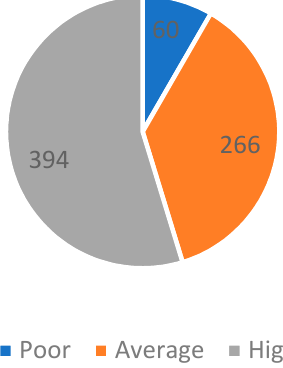
Figure 3. Patients’ satisfaction grade for telemedicine ( n = 720). In the present study, we performed binomial logistic regression analysis to find the associated factors for poor and average patient satisfaction towards telemedicine. satisfaction scores were age group more than 40 years (OR = 1.59; 95% CI = 1.04–2.44, p = 0.031), education less than University/College level (OR = 1.68; 95% CI = 1.07–2.15, p = 0.025), patients attending a specialty hospital (OR = 1.73; 95% CI = 1.21–2.47, p = 0.03), and patients who had never had a telemedicine experience before (OR = 3.28; 95% CI = 2.32– 4.65, p < 0.001) (Table 4).